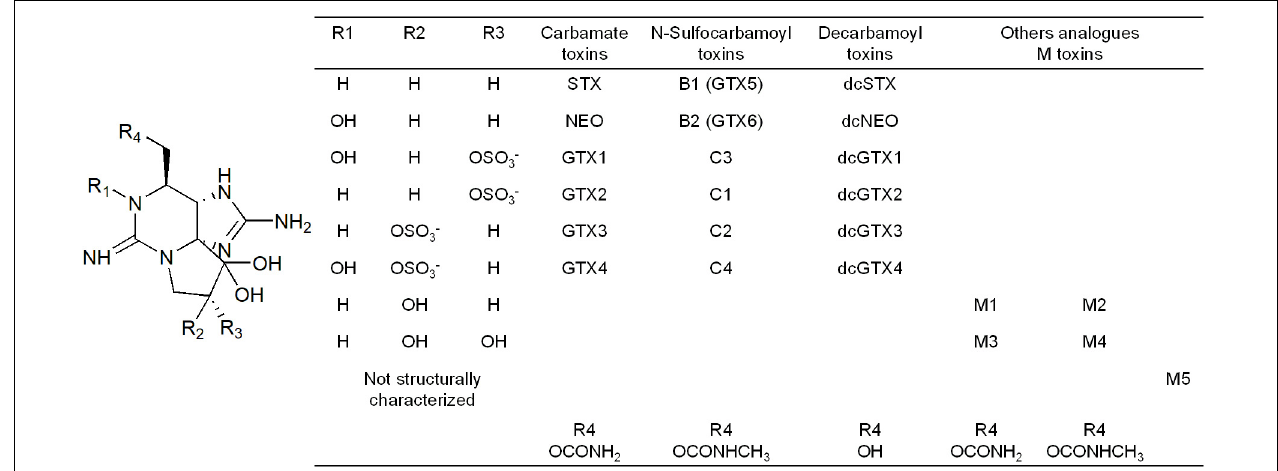
FIGURE 1 | Structure of the paralytic shellfish primary toxin analogs, grouped according to the molecular substitutions.